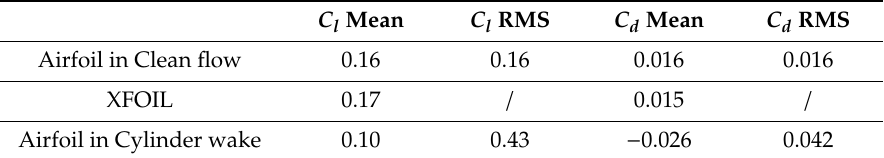
Table 4. Mean and RMS force coefficient of airfoil.